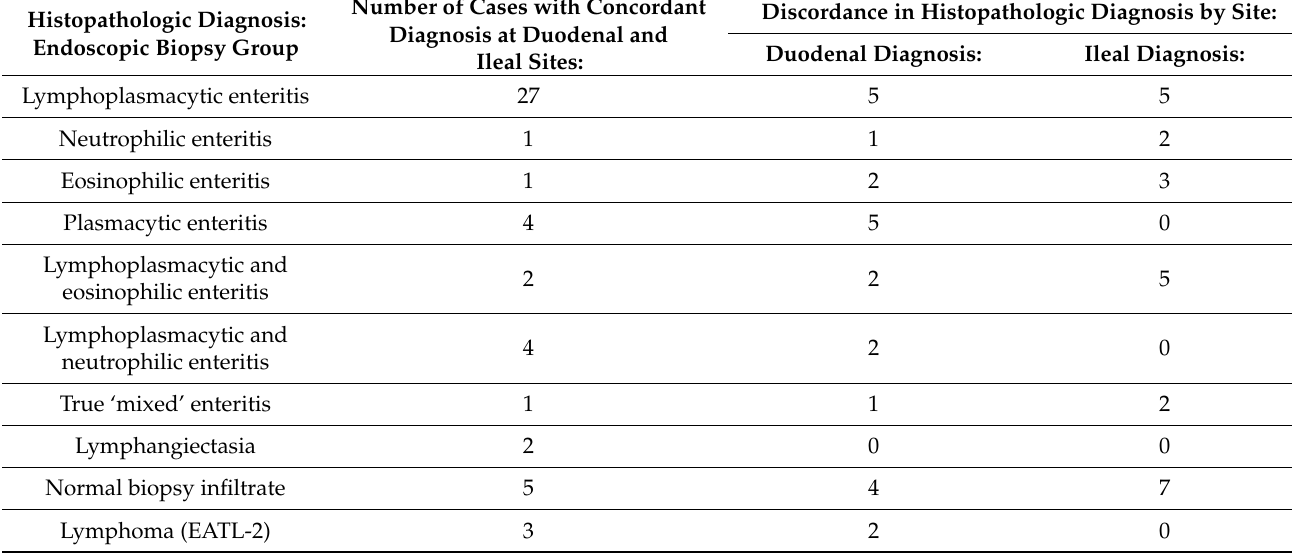
Table 1. Final histopathologic diagnosis following re-review of slides within the endoscopic biopsy group of inflammatory or neoplastic disease (74 dogs). Concordant cases represented first, followed by discordant cases where individual corresponding diagnosis per site is